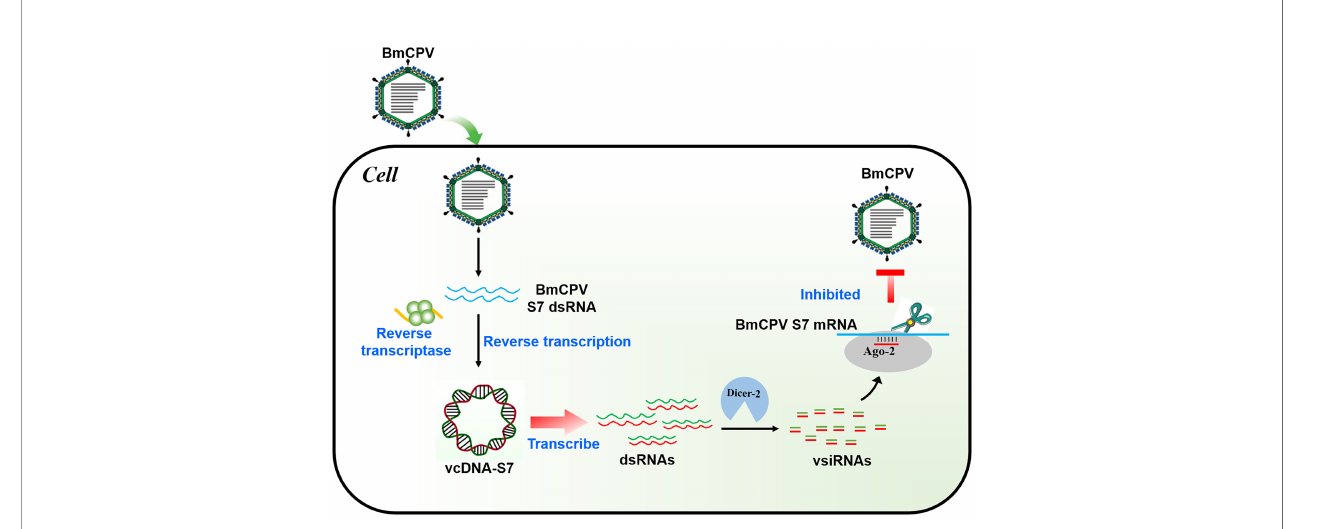
FIGURE 8 | Mechanism of BmCPV-derived circular DNA vcDNA-S7 controlling BmCPV infection. Silkworm infected with BmCPV produce viral-derived vcDNA-S7 mediated by reverse transcriptase. vcDNA-S7 can be transcribed to RNA and produce vsiRNAs to control BmCPV infection by RNAi